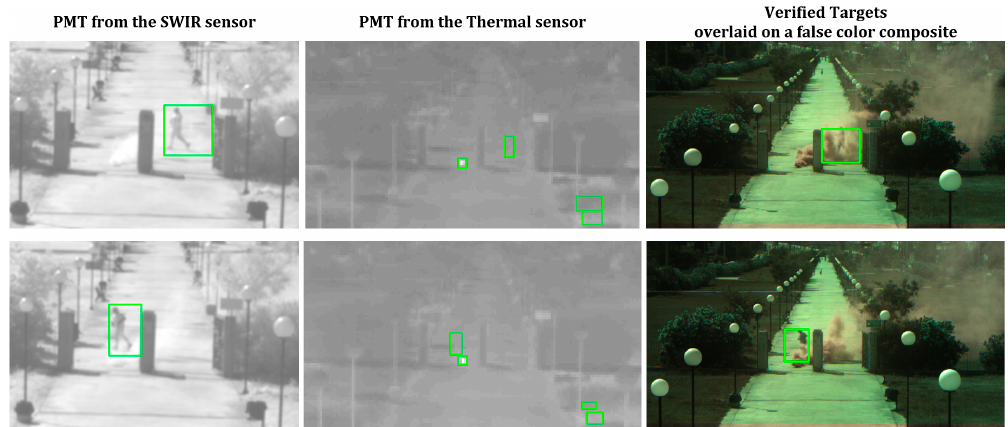
Figure 6. The possible moving targets (PMT) from the SWIR (left) and thermal (middle) sensors are projected through the LCS onto the hyperspectral data cube and the associated/verified targets are detected (right). Indicative results for frame #118 (top) and frame #123 (down) from the outdoor scene dataset are presented.